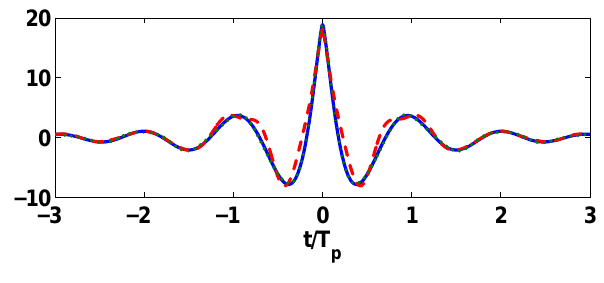
Fig. 6. The maximal signals corresponding to the original Jonswap spectrum (solid), the free-wave spectrum (dashed) and correspond- ing to the free-wave spectrum with nonlinear contributions (dotted, behind the solid